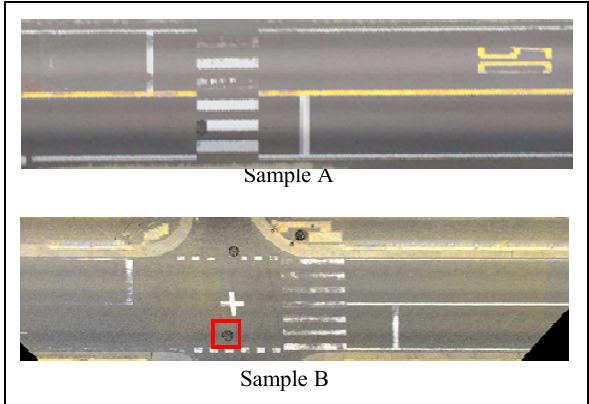
Figure 15. Correction result